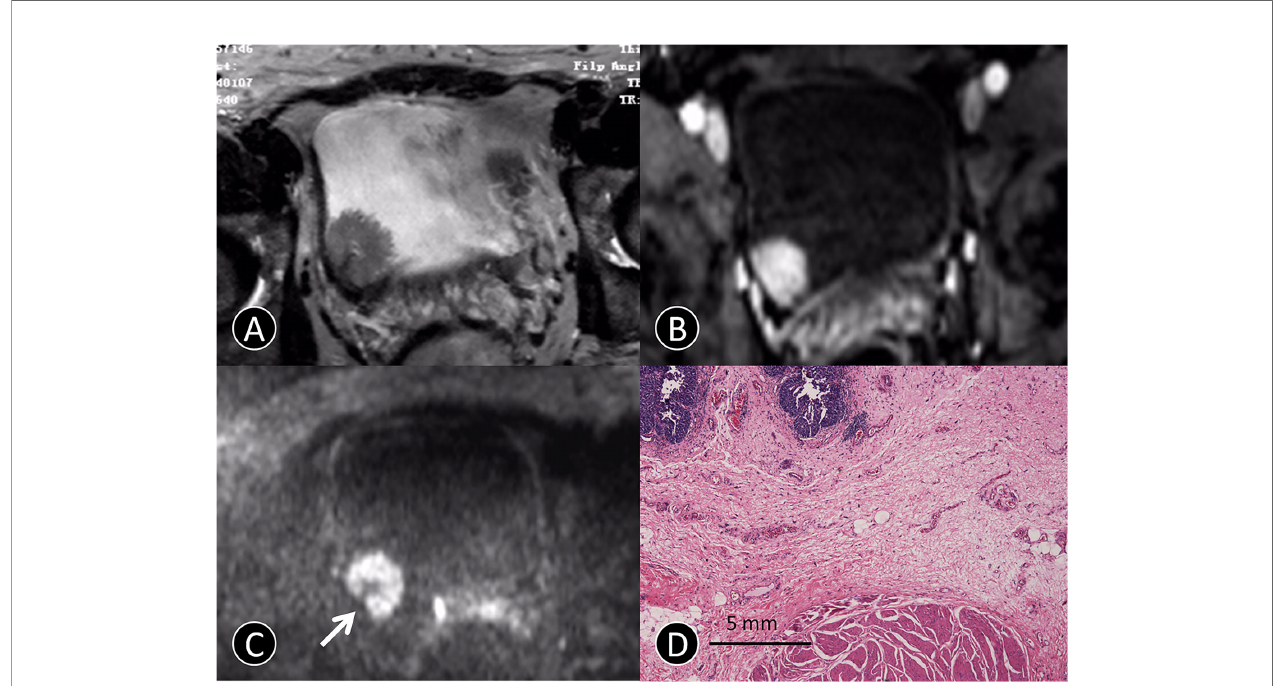
FIGURE 1 | MR images of a 72-year-old man with pTa urothelial carcinoma. (A) The transverse T2 SPAIR image shows an oval mass on the right bladder wall without obvious a C-shaped high SI area (arrow). (B) The transverse DCE image shows an oval mass that is signi fi cantly enhanced, and the submucosa is slightly enhanced without obvious a C-shaped high SI area (arrow). (C) The transverse DW MR image shows a C-shaped high SI area with a low SI stalk connecting to the right side of bladder wall with a thin pedicle and small contact area (arrow). (D) The photomicrograph of a specimen obtained at TUR shows papillary cancer (blue) with a submucosal stalk (red line) consisting of markedly edematous submucosa, fi brous tissue, capillaries, and mild in fl ammatory cell in fi ltration (Hematoxylin-eosin staining; original magni fi cation,